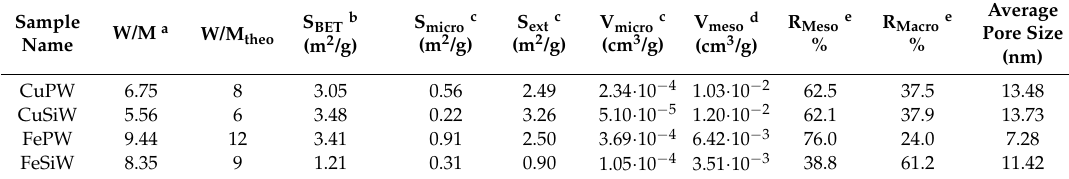
Table 1. Compositions and textural properties of the as-synthesized heteropolyacid salt samples. Sample